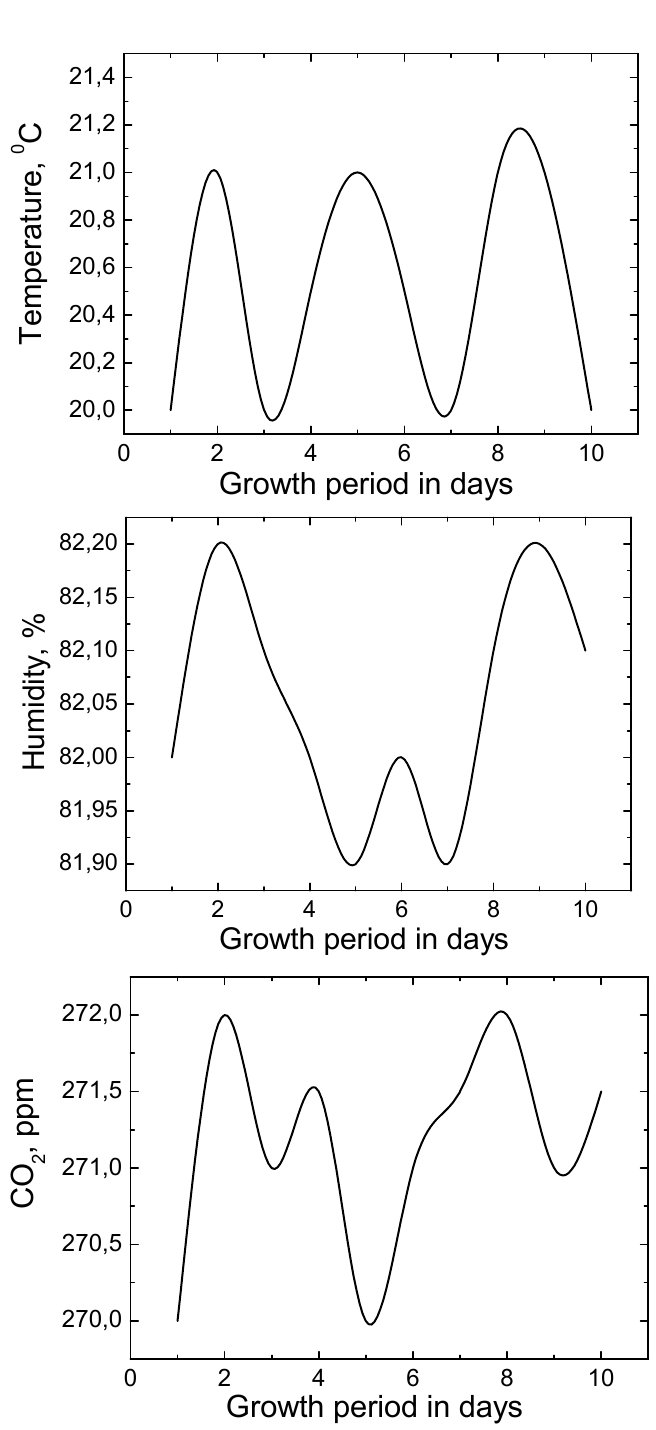
Figure 13. Changes in temperature, humidity and CO 2 parameters during the growth cycle of Shiitake mushrooms.